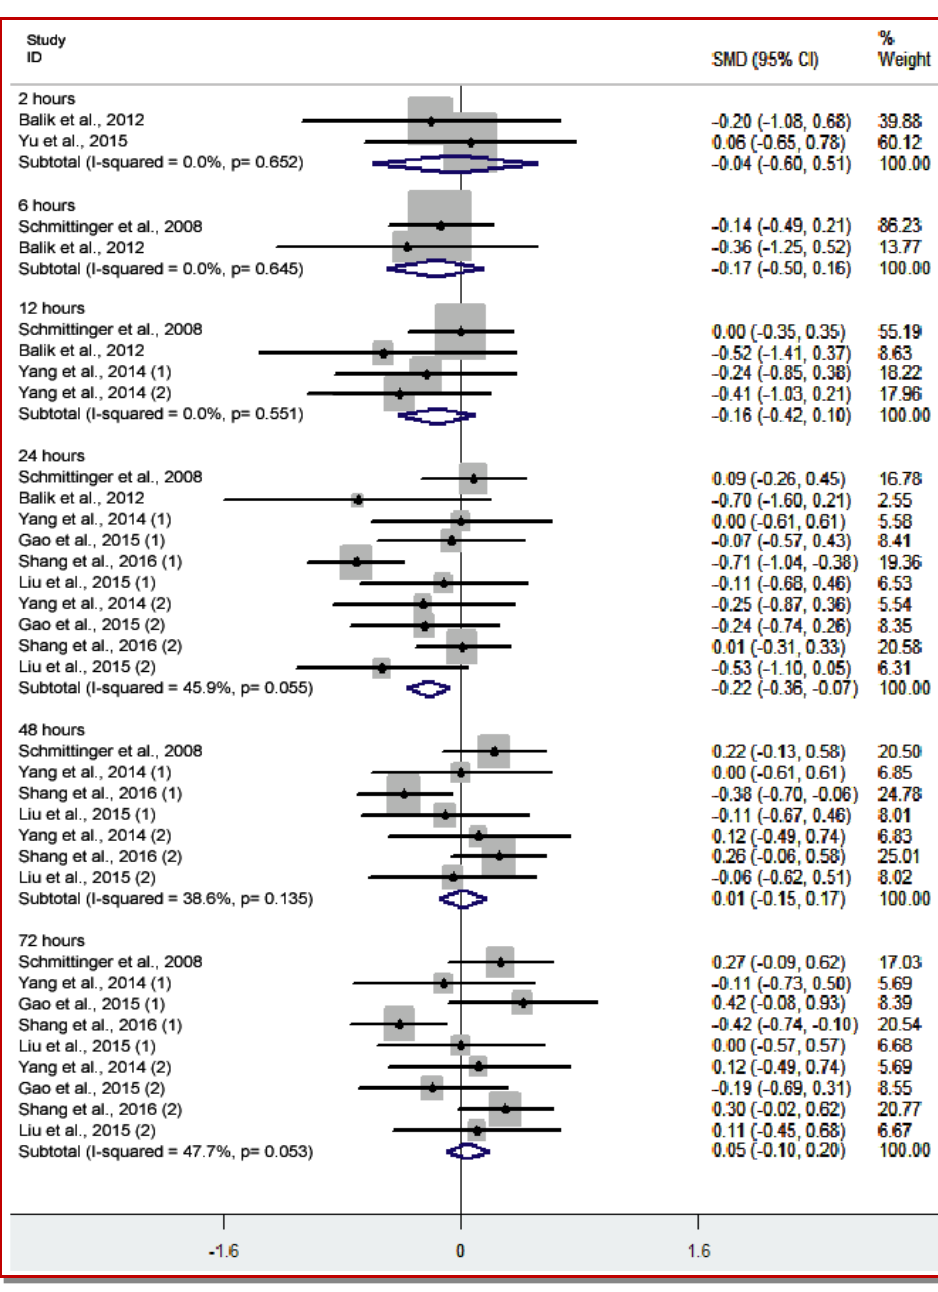
Figure 4: Meta-analysis of β -blocker on the mean arterial pressure (digit within the parenthesis means the number of studies for